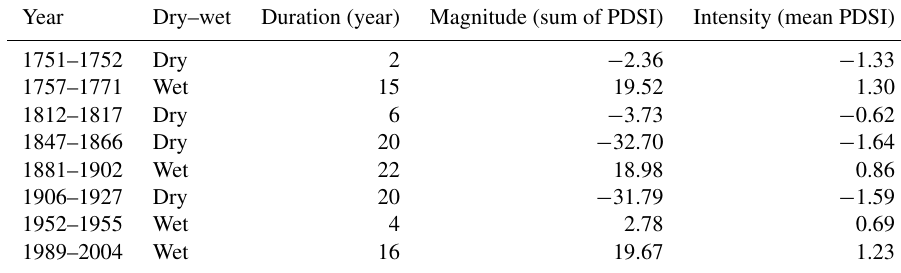
Table 5. The long-term droughts and pluvial in the central Daxing’an Mountains during the last 260